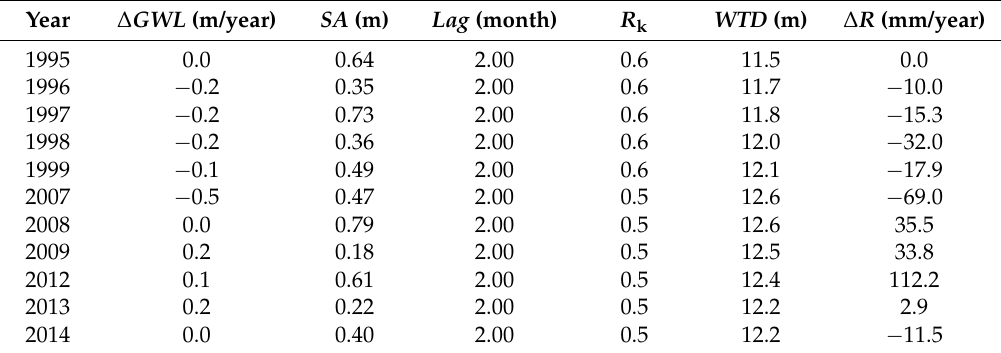
Table 6. Sample data from a piezometer (Pz05) used for the spatiotemporal PCA.